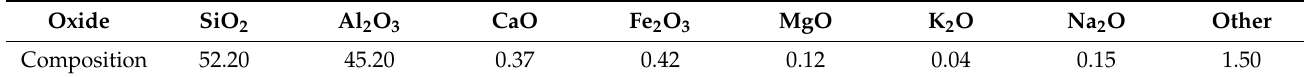
Table 3. Chemical constitution of ceramic powder. Table 2. Main physical performance of aggregates.